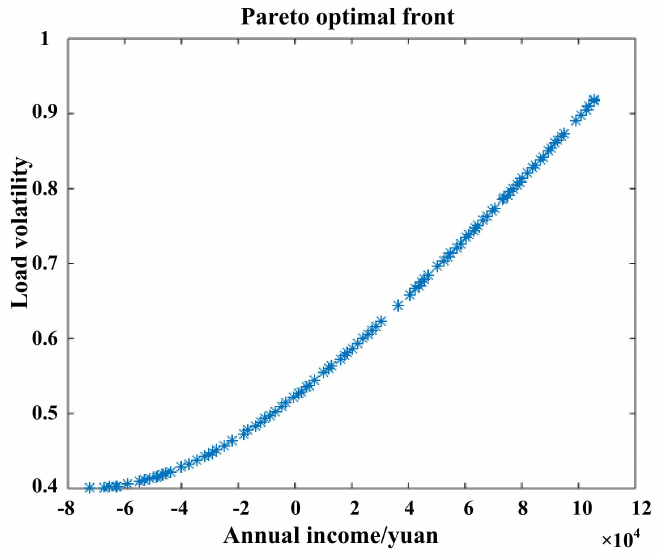
Figure 5. User’s load volatility–annual income relationship